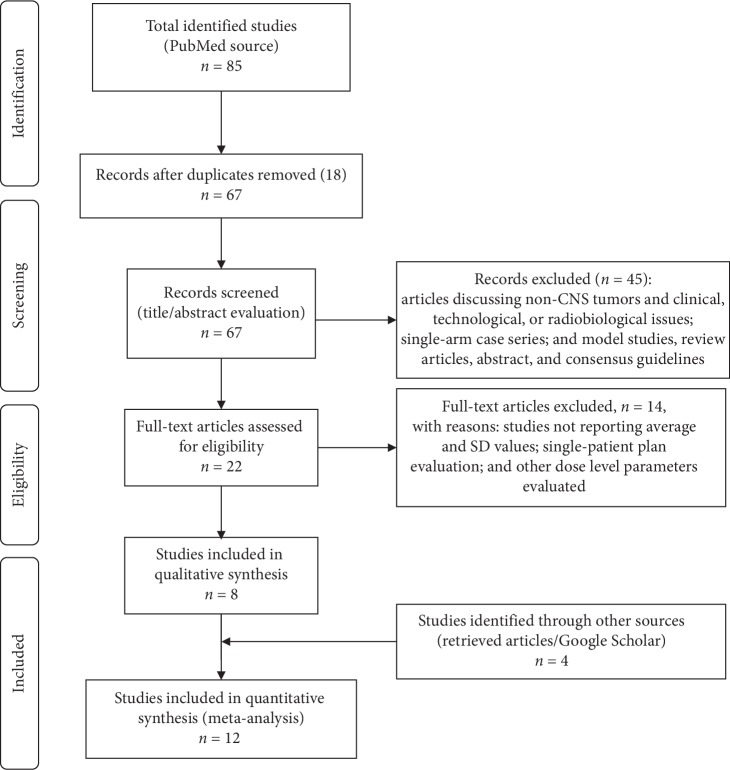
Flow chart of the research strategy according to the PRISMA statement [9].